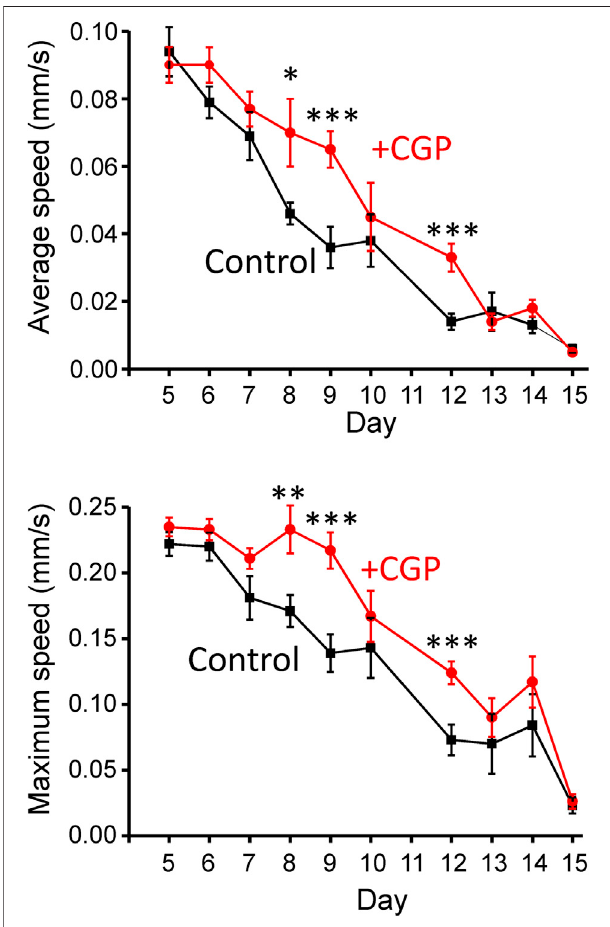
FIGURE 3 | Effect of CGP37157 on the mobility of the worms. Mobility was estimated from 2 min videos analyzed with the “ wrMTrck ” ImageJ plugin to obtain the mean average and maximum speed, as described in Methods. * p < 0.05; ** p < 0.01; *** p < 0.005, ANOVA test, n (cid:2) 9 – 15 worms per condition.